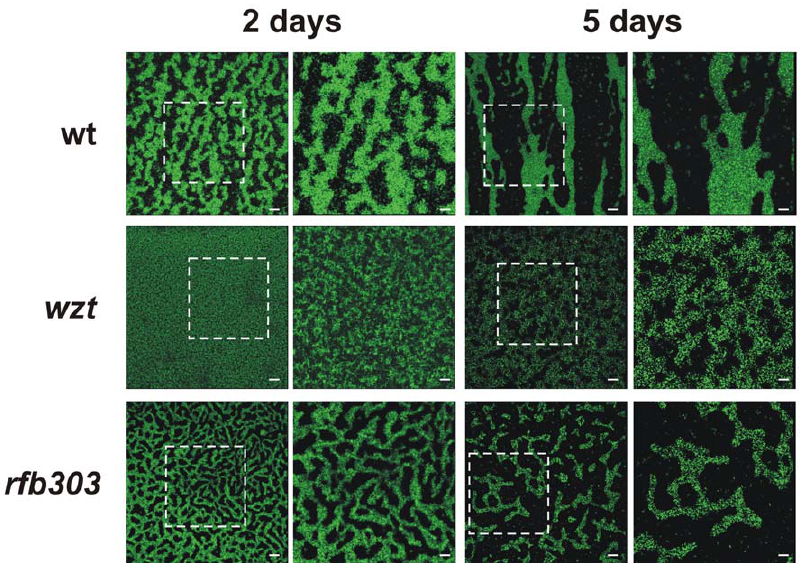
Figure 5. Biofilm formation. GFP-labeled Xac strains were grown on chambered cover slides and visualized under CLS microscopy after 2 and 5 days of bacterial growth. For each time period the left panels show cell aggregation at the bottom of the chambered cover slides with a magnification of 40 6 and the right panels show a 2 6 zoom of the regions marked in the previous panels. Scale bars, 50 m m.